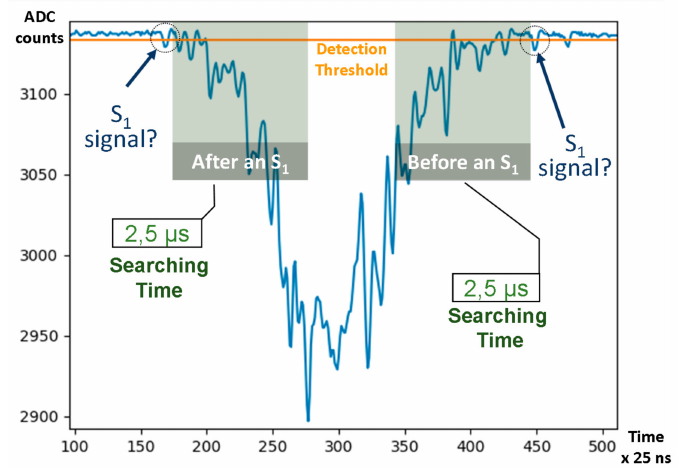
Figure 7. Run 7979 83m Kr energy deposition signal (S 2 ) in PMT0 with possible false S 1 signals after and before the S 2 signal that could be set as possible event